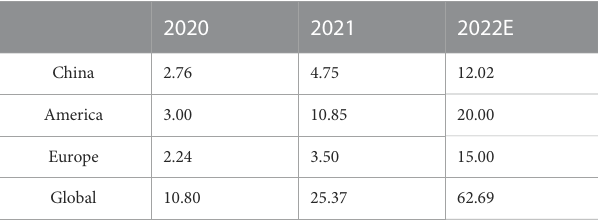
TABLE 1 Energy storage installed in major countries and the world